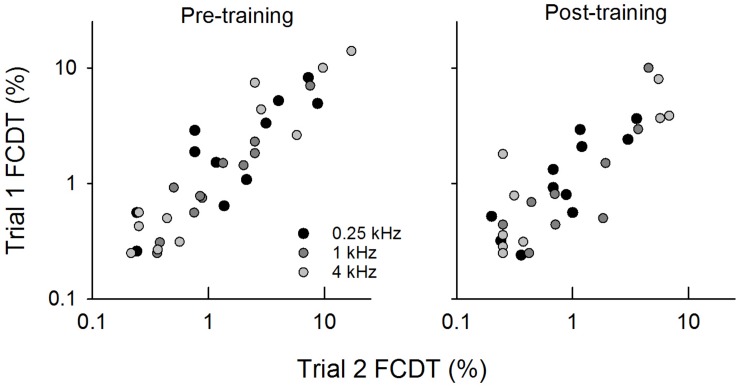
The scatterplots of FCDTs measured from trial 1 vs. trial 2 at pre- and post-training testing.